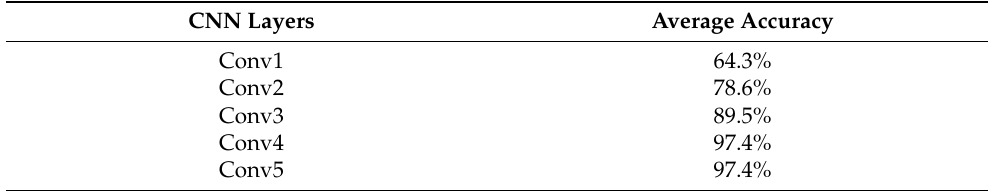
Table 3. Classification accuracy vs. CNN